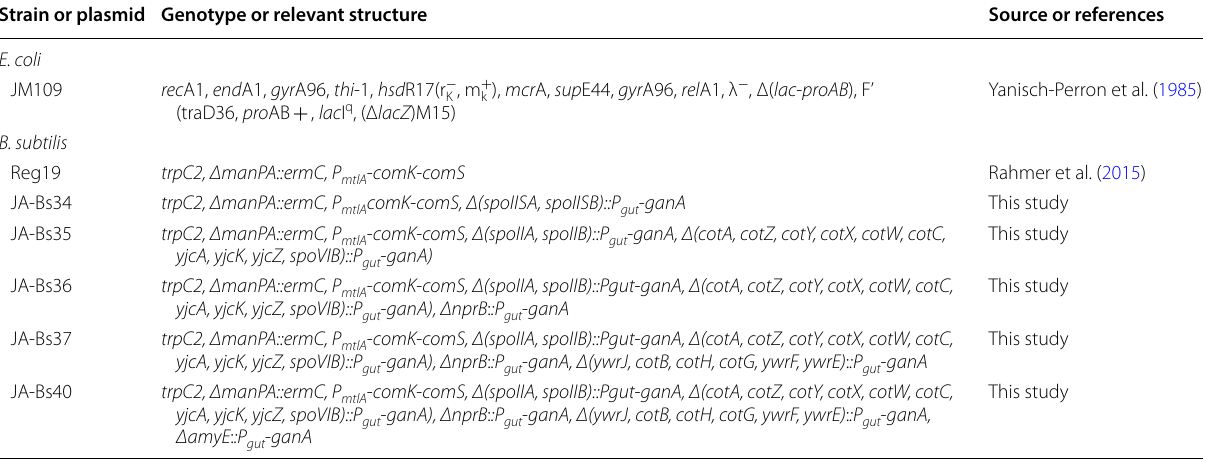
Table 1 Strains used in this study Strain or plasmid Genotype or relevant